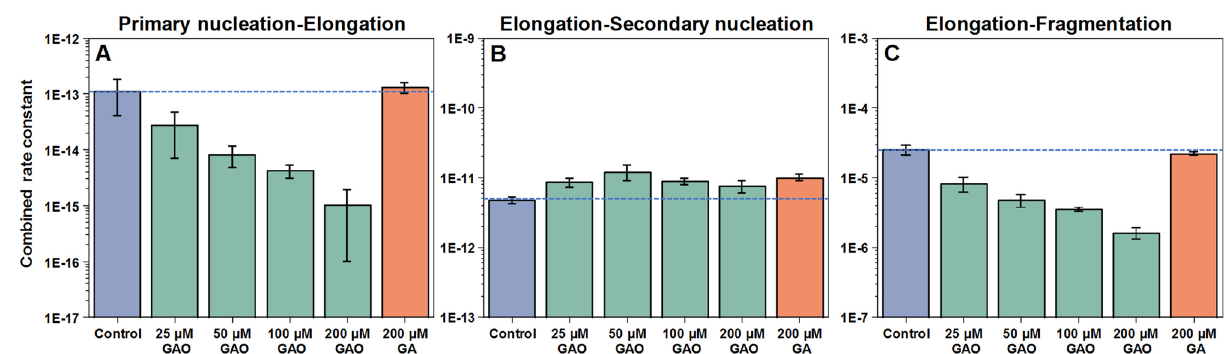
Figure 3. Insulin aggregation primary nucleation-elongation ( A ), elongation-secondary nucleation ( B ) and elongation-fragmentation ( C ) combined rate constants when there is 200 µM GA or different GAO concentrations present in solution. Rate constants were obtained by global-fitting the entire concentration range (0.2–1.0 mM) of insulin aggregation kinetic data at a specific GA or GAO